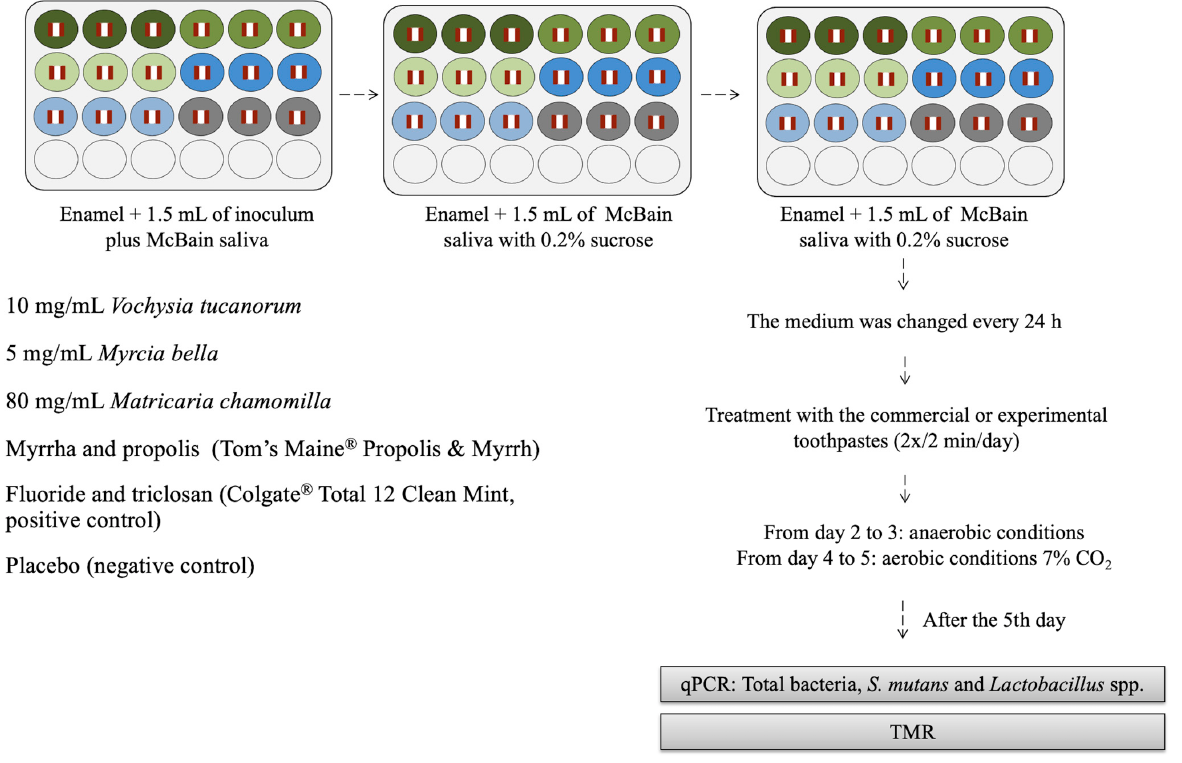
Figure 1. Experimental microcosm biofilm protocol as well as the correspondent treatments and the response variables applied to analyze the biofilm and the tooth.